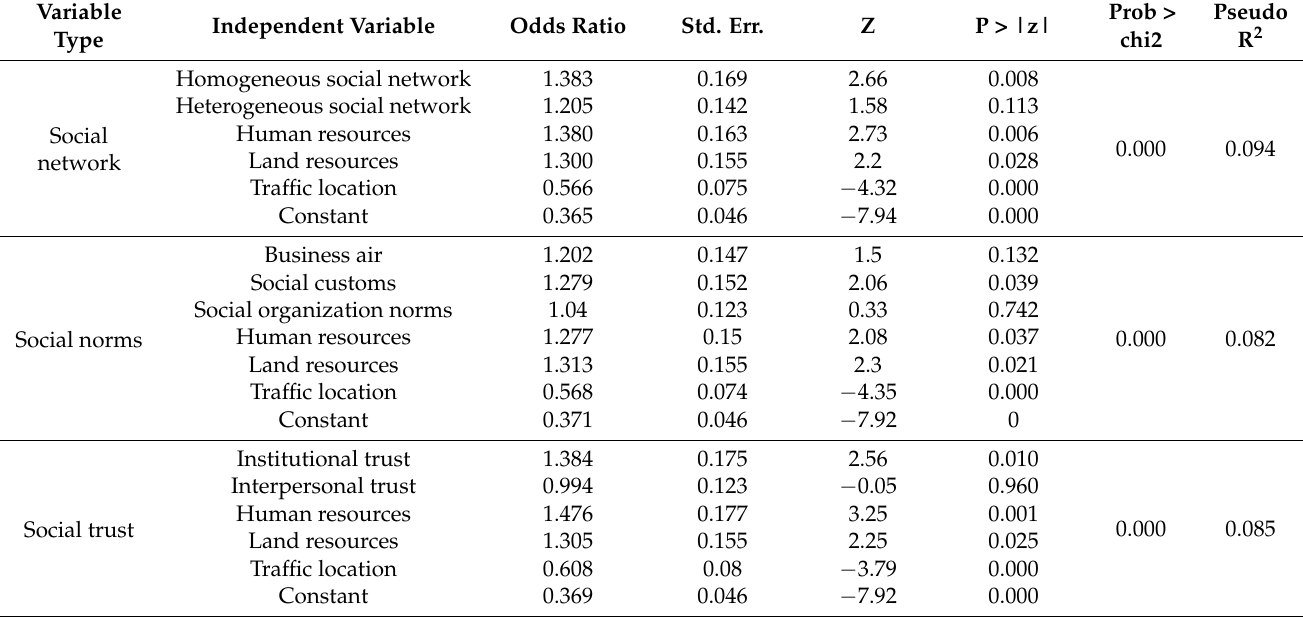
Table 2. Impact of social capital on grape planting decisions in